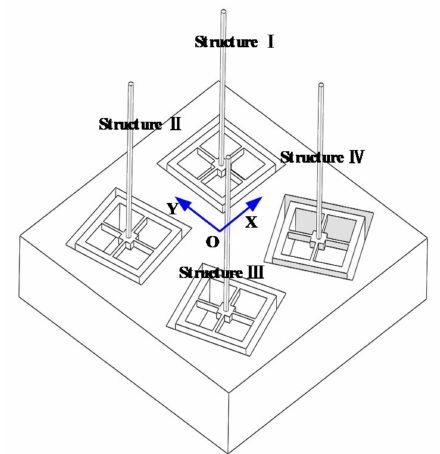
Figure 5. Overall design of the array